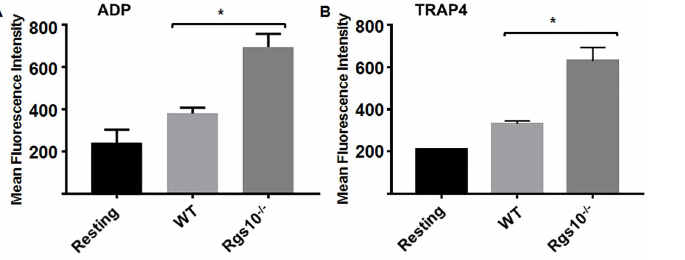
Fig 4. Deletion of RGS10 protein causes enhanced integrin α IIb β 3 activation in stimulated platelets. Platelets from Rgs10 -/- or WT mice (10 5 platelets/100 μ l) were stimulated with (A) 5 μ M ADP and (B) 80 μ M TRAP4, fixed, and labeledwith JonA antibody. Samples were analyzedusing a flow cytometer. Average mean fluorescence intensities shown. Experimentwas conducted in duplicate,and was repeated at least 3 times, with blood pooledfrom a group of eight mice. (P < 0.05 using Unpairedt-test).